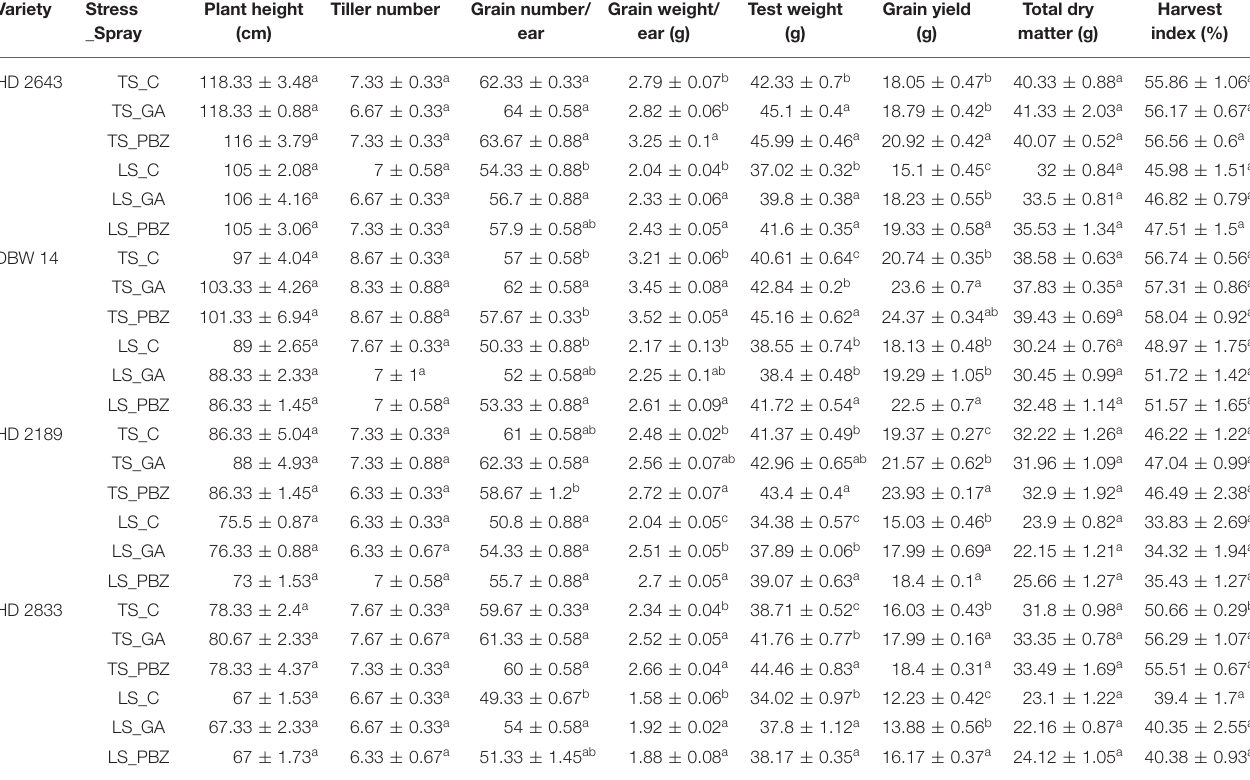
TABLE 1 | Effect of post-anthesis application of gibberellic acid (100 ppm) and paclobutrazol (50 ppm) on plant height (cm), tiller number per plant, grain number/ear, grain weight per ear (g), test weight, grain yield (g/plant), and total dry weight (g/plant) in wheat exposed to timely and late sown conditions.